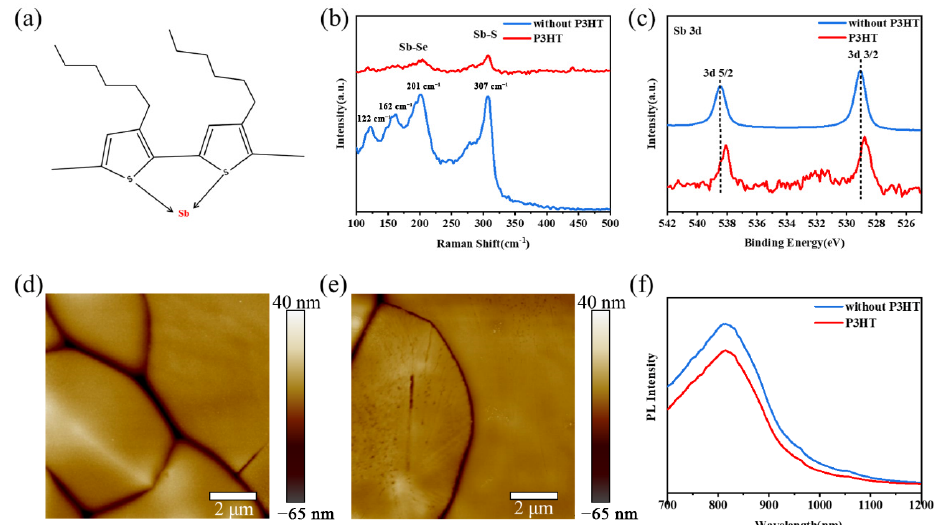
Figure 5. ( a ) Scheme of chelating interaction between P3HT and Sb. ( b ) Raman and ( c ) XPS spectra of the Sb 2 S 3 /Sb 2 (S, Se) and Sb 2 S 3 /Sb 2 (S, Se) 3 /P3HT films. AFM images of the ( d ) Sb 2 S 3 /Sb 2 (S, Se) 3 and ( e ) Sb 2 S 3 /Sb 2 (S, Se) 3 /P3HT films. ( f ) Steady-state PL spectra of the Sb 2 S 3 /Sb 2 (S, Se) 3 and Sb 2 S 3 /Sb 2 (S, Se) 3 /P3HT films.